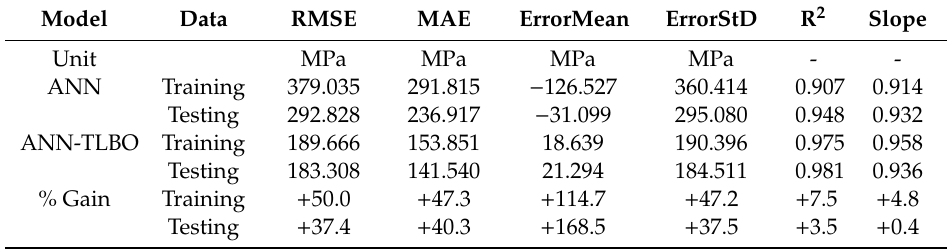
Figure 7. Regression graphs using individual ANN model: ( a ) training and ( b ) testing parts; ANN- TLBO model: ( c ) training and ( d ) testing parts. Table 6. Summary of prediction capability of the ANN-TLBO Table 6. Summary of prediction capability of the ANN-TLBO model.